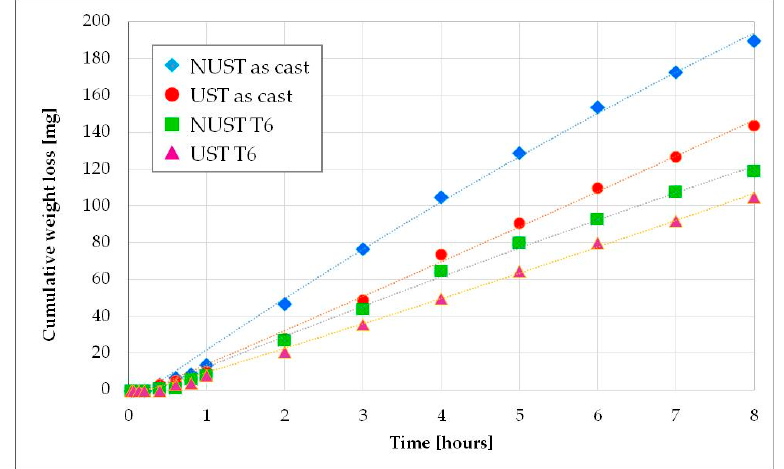
Figure 7. Cumulative mass loss vs time.